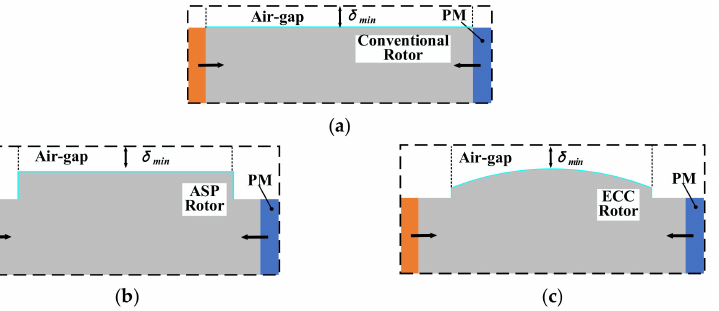
Figure 2. Topological optimization in the spoke PM motors. ( a ) Model 1. ( b ) Model 2. ( c ) Model